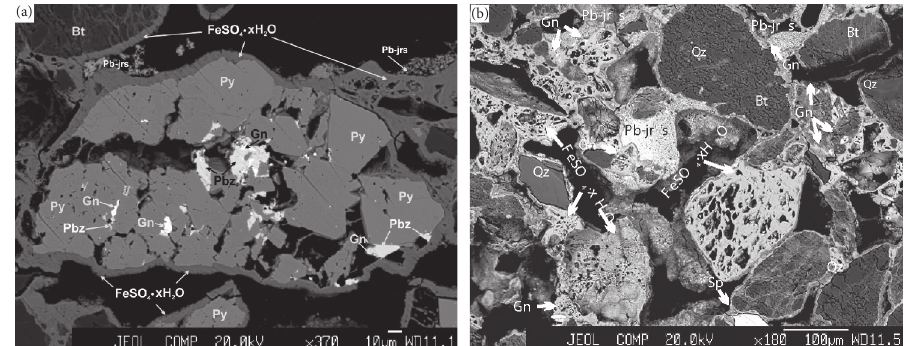
Figure 2: The prevailing mineral forms in mature concentration tailings; (a) isometric grains of galena in pyrite metacrystals, eroded pyrite crystal, and new formations of iron sulfates; (b) plumbojarosite and other hypogene and hypergene minerals: Bt, biotite, Gn, galena,